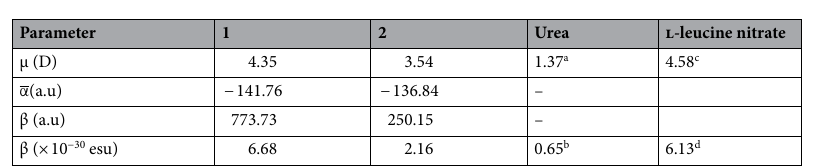
Table 6. Calculated total dipole moments (µ), average linear polarizability ( α ) and the first hyperpolarizability (β) and for the Schiff base compounds. a 54 , b, c, d 55 .